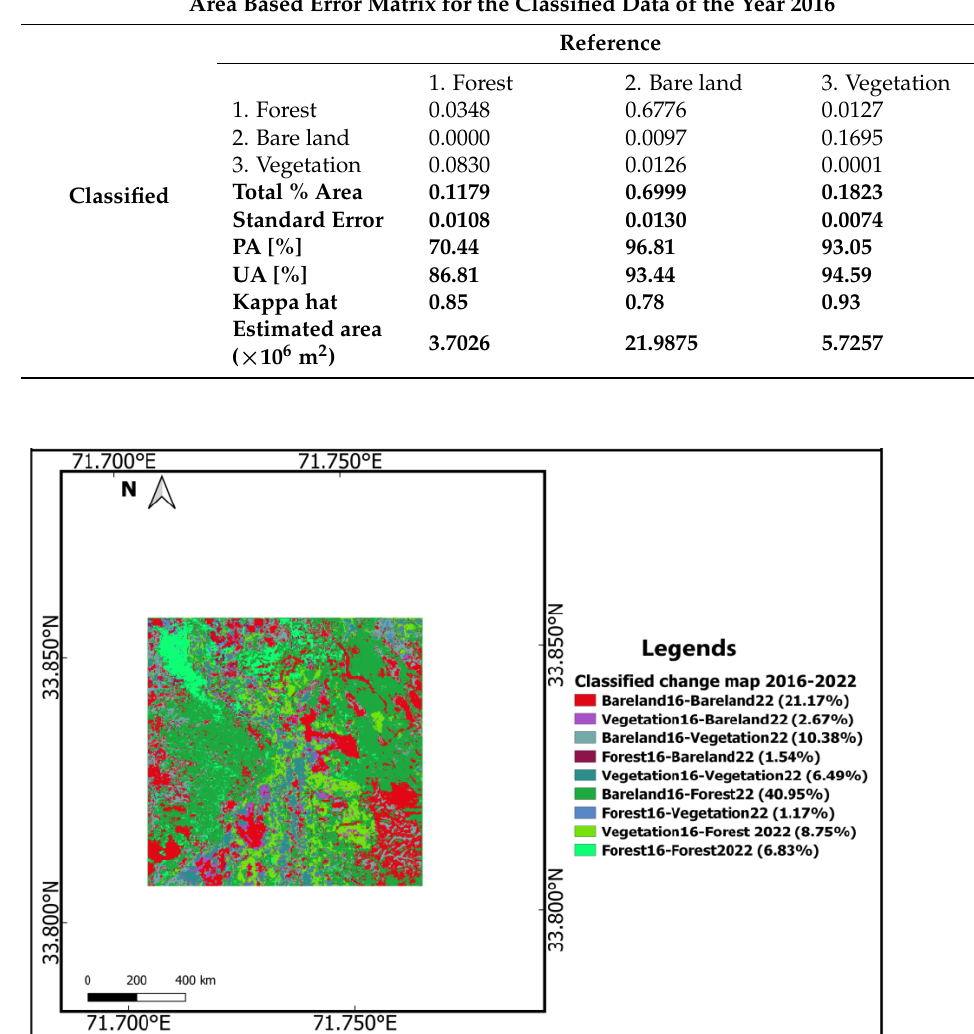
Table 14. Accuracy assessment parameters for the classified data of the year 2016.